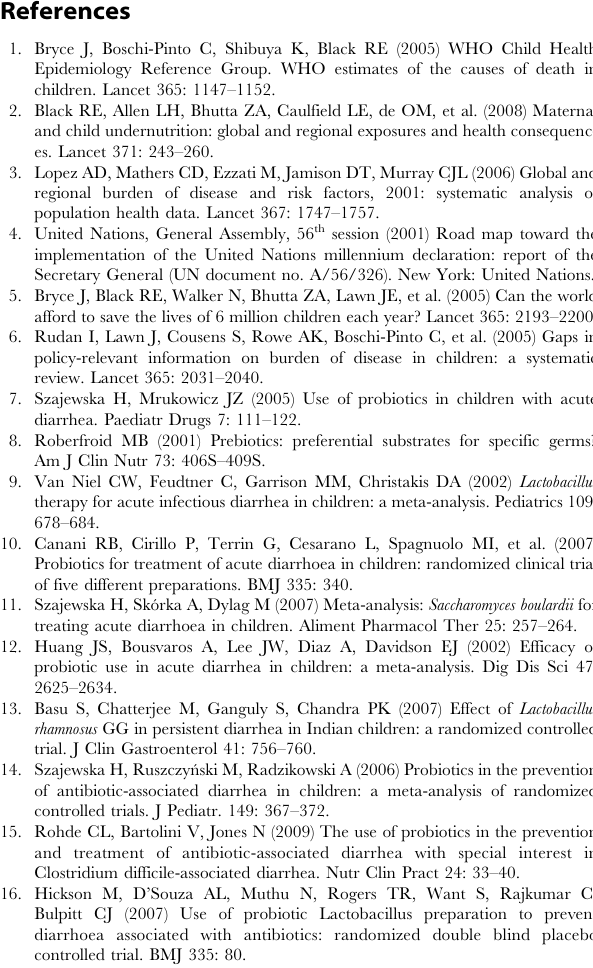
Table S5 Effect of prebiotic oligosaccharide and probiotic Bifidobacterium lactis HN019 and fortified milk on common childhood morbidities (among malnourished children).